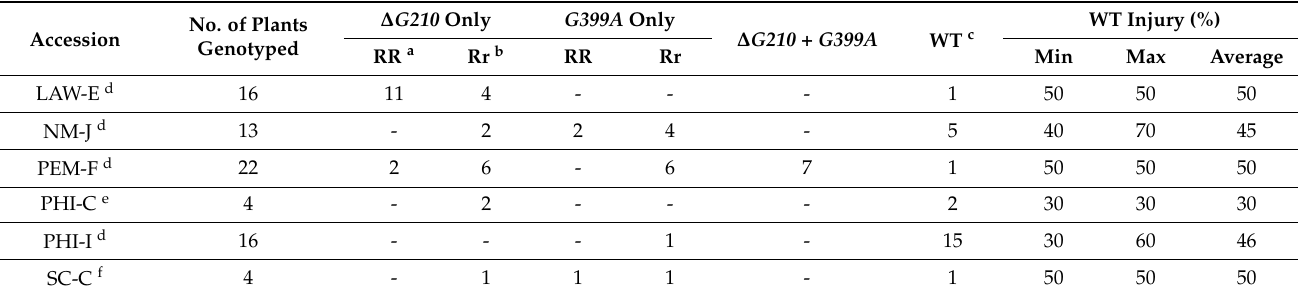
Table 5. Genotype and zygosity of Amaranthus palmeri survivors from treatments with 280, 560, and 1120 g ha − 1 fomesafen